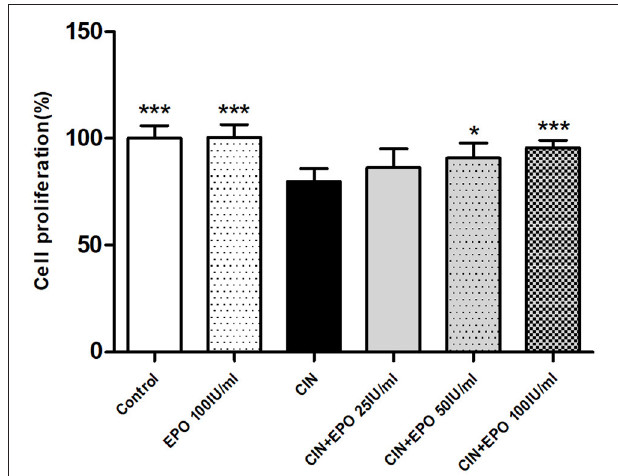
FIGURE 4 | Change of proliferation rate in each group. Cell Counting Kit-8 assay was used to determine the proliferation rate. Data are expressed as mean ± S.D. * P < 0.05, *** P < 0.001 vs. the CIN group. EPO, erythropoietin; CIN, contrast-induced